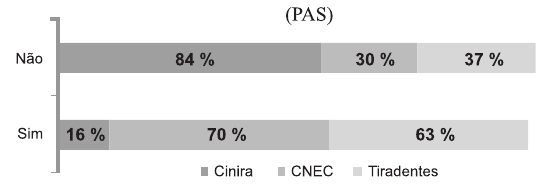
Figura 4. Participação dos estudantes das três es- colas pesquisadas no Programa de avaliação Seriada da UFla (PaS). Total de estudantes: 61 no cinira, 110 no Tiradentes e 99 na